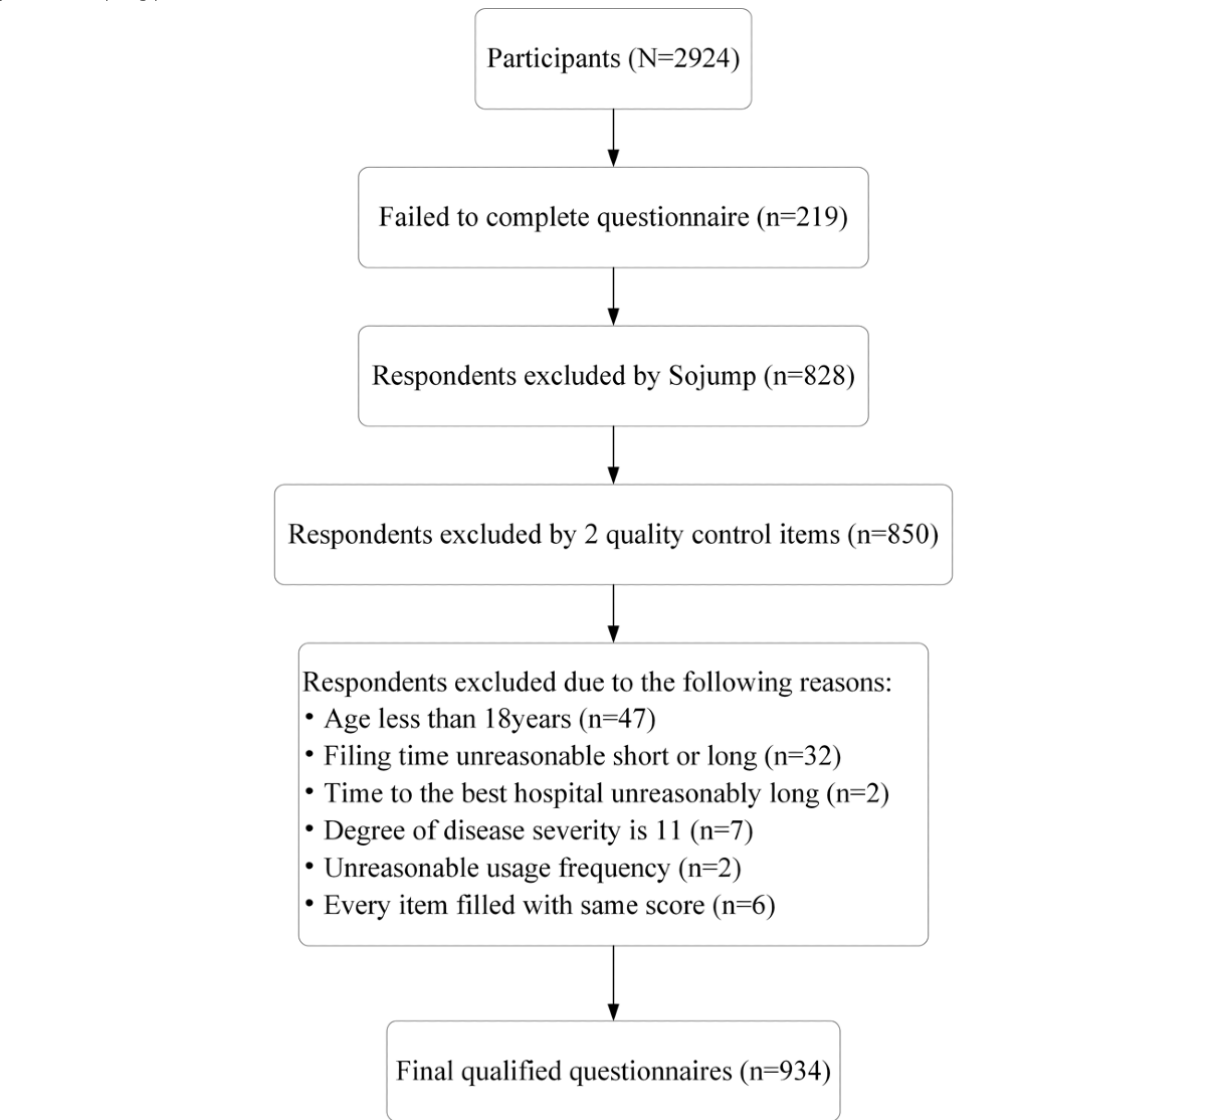
Figure 2. Sampling